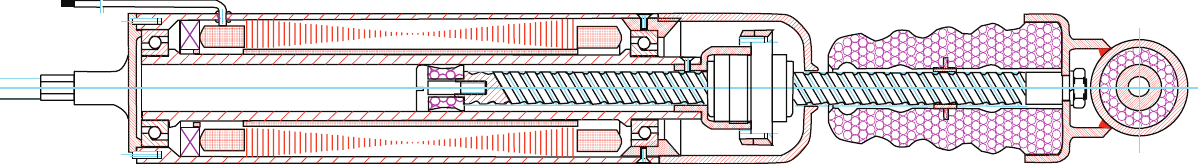
Figure 7: Section view of the ball screw type actuator.